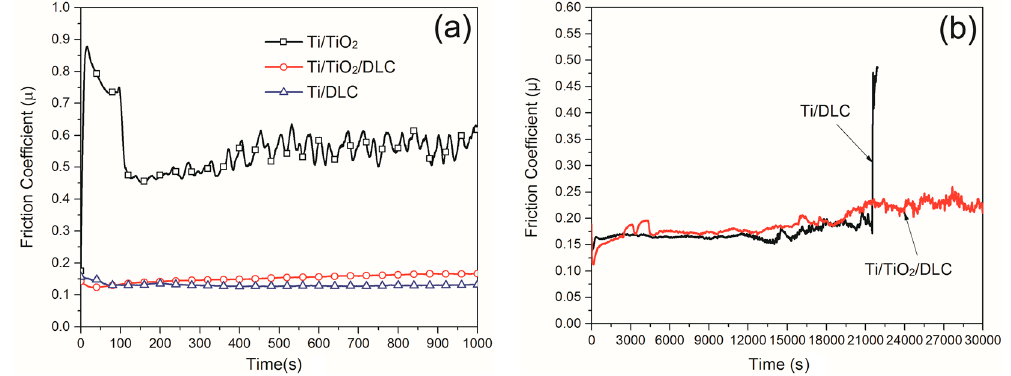
Figure 4. The relationship between the friction coefficient and the wear time of samples under different normal load: ( a ) 1 N; ( b ) 10 N.